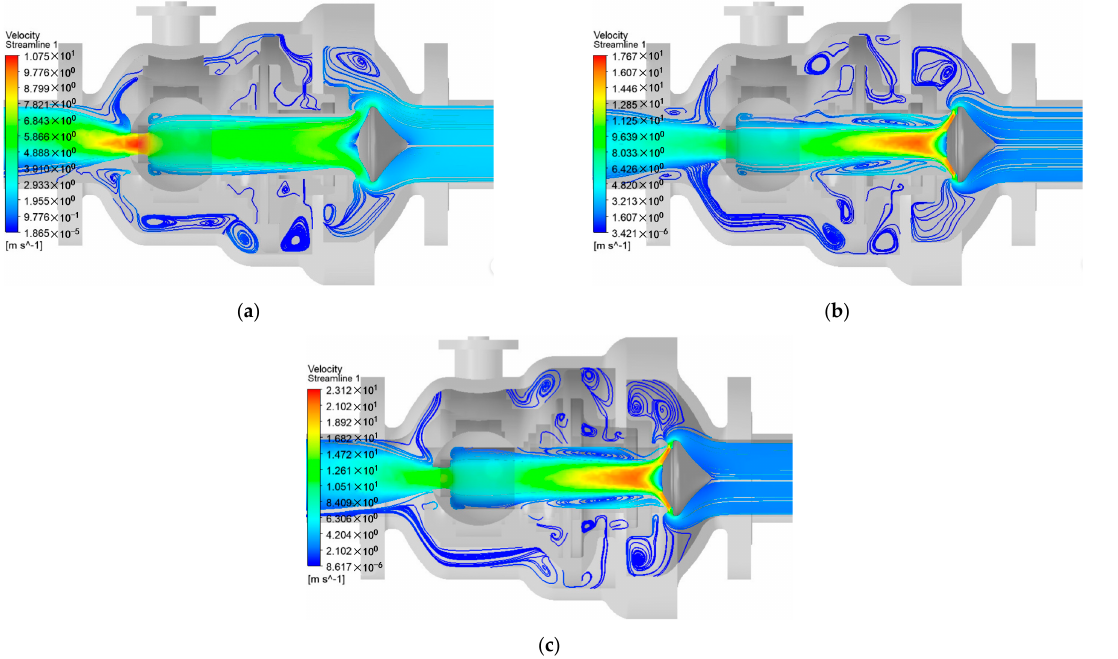
Figure 12. Velocity field of dynamic flow balance valve. ( a ) ∆ P = 30 kPa, the 0 s moment of the moving mesh. ( b ) ∆ P = 150 kPa, the 0.26 s moment of the moving mesh. ( c ) ∆ P = 270 kPa, the 0.53 s moment of the moving mesh.